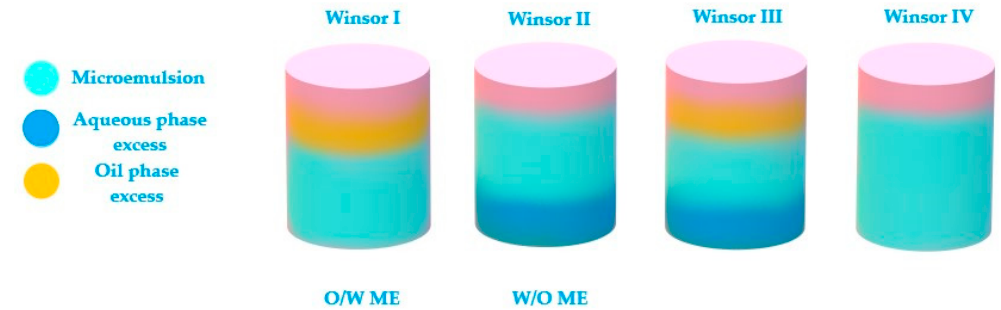
Figure 6. Schematic representation of Winsor phases I, II, III and IV, explaining the transition of phases from Winsor phase I to Winsor phase IV to obtain an ideal system.